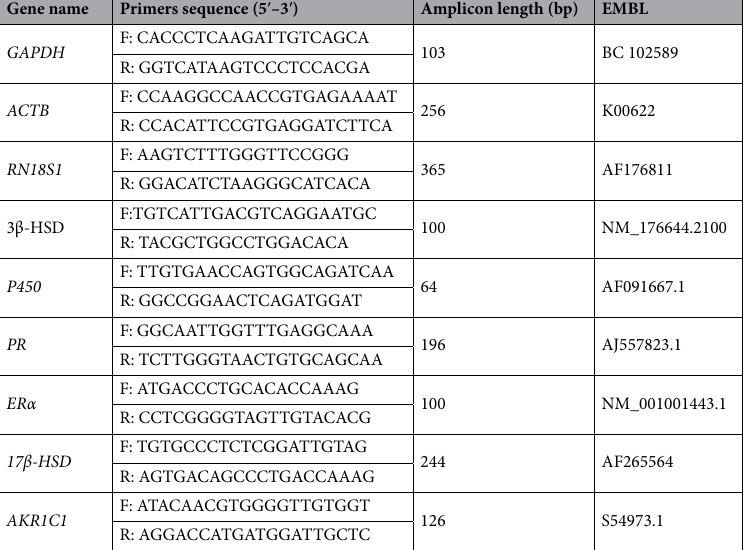
Table 1. Oligonucleotide sequences used for Real-time PCR. GAPDH Glyceraldehyde 3-phosphate dehydrogenase, RN18S1 18S ribosomal RNA, ACTB β-actin, AKR1C1 aldo–keto reductase family 1 member C1, 3β-HSD 3-beta-hydroxysteroid dehydrogenase, 17β-HSD 17-beta-hydroxysteroid dehydrogenase, P450 cytochrome P450 aromatase, ESR1 estrogen receptor 1, PR progesterone